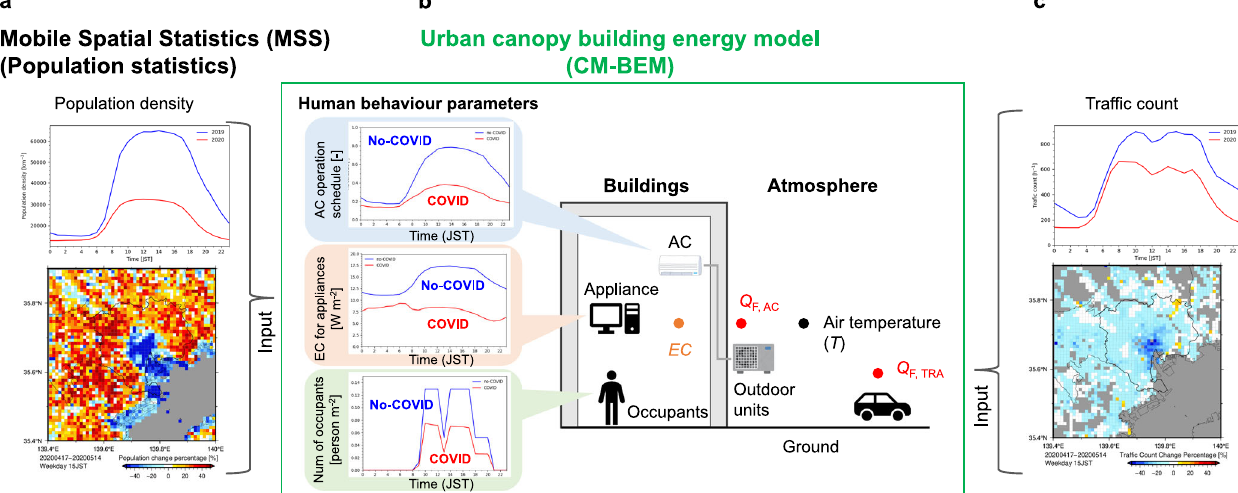
Fig. 4 Schematic view of an integration of urban-building-energy-model with social big data. a MSS, b UCM-BEM, and c traf fi c count data. The red and blue lines indicate human behaviours in the COVID and No-COVID cases,